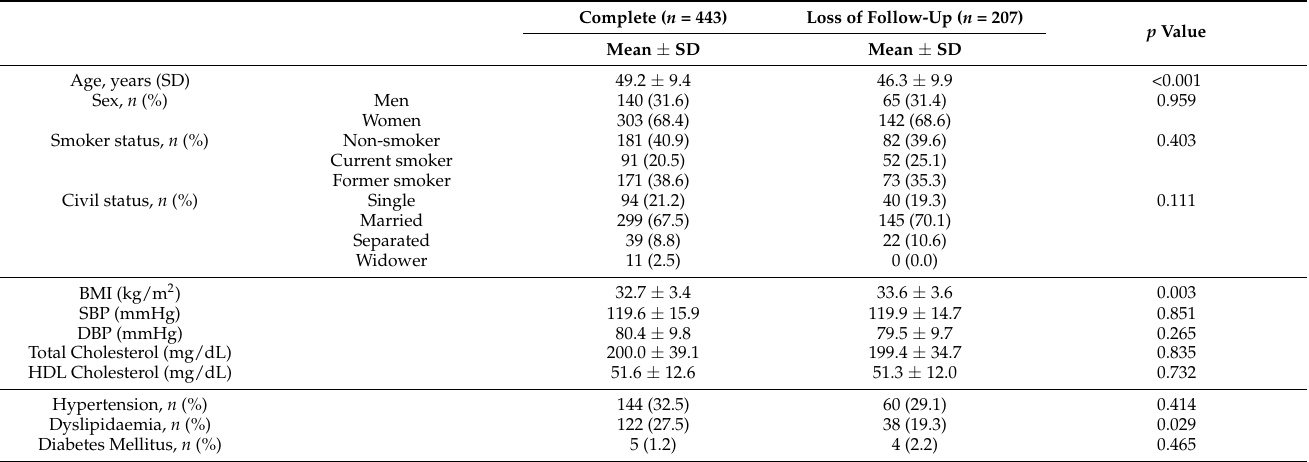
Table A1. Baseline characteristics comparison between participants who completed the study and those who dropped